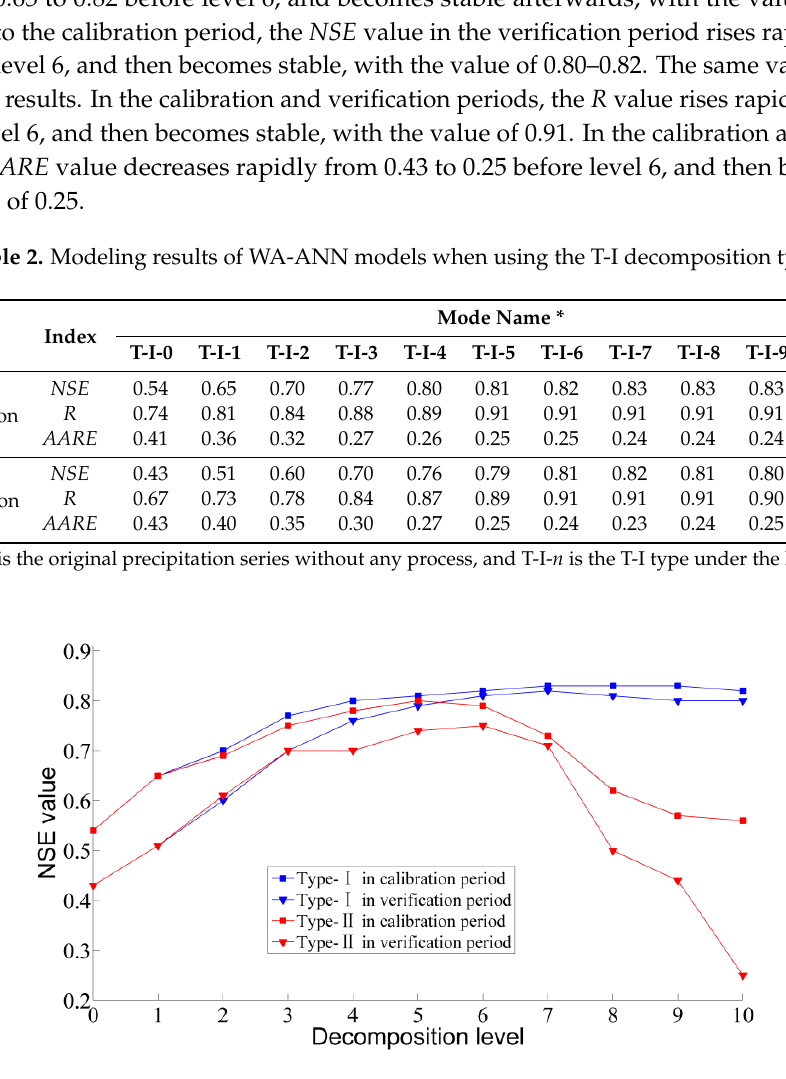
Table 2. Modeling results of WA-ANN models when using the T-I decomposition type.